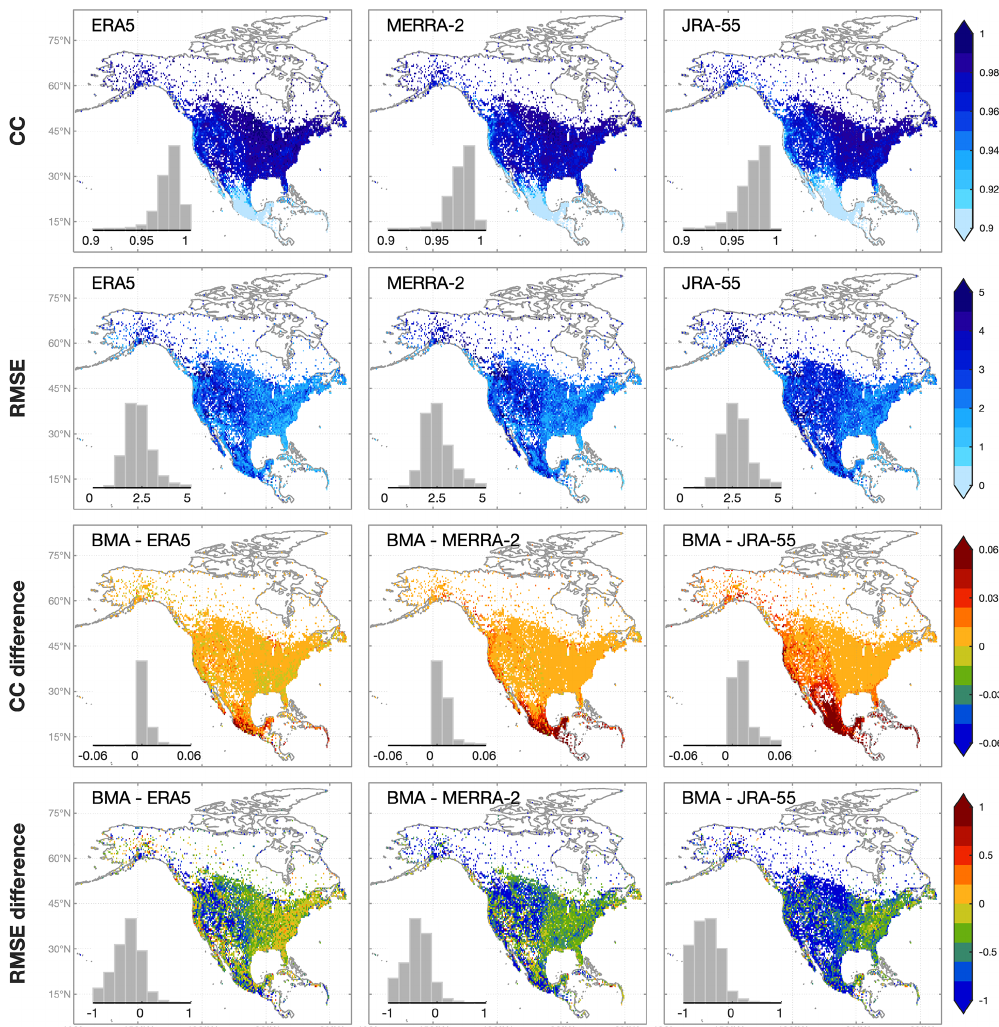
Figure 4. Same as Fig. 3 but for mean